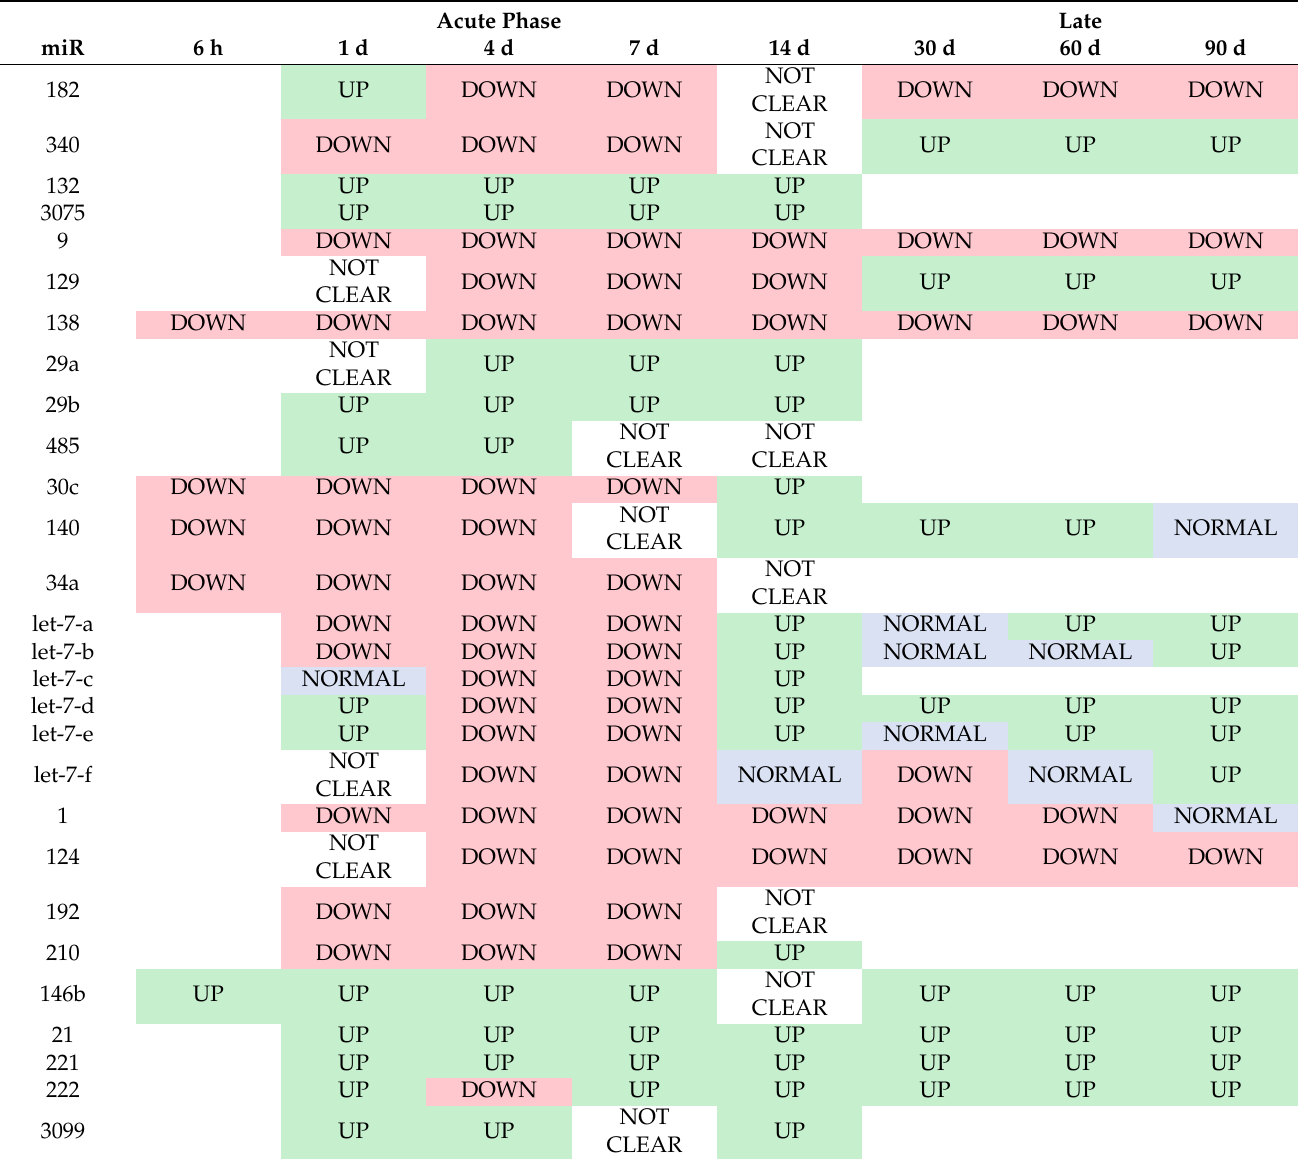
Table 3. miRNA-expression profiles generated from literature